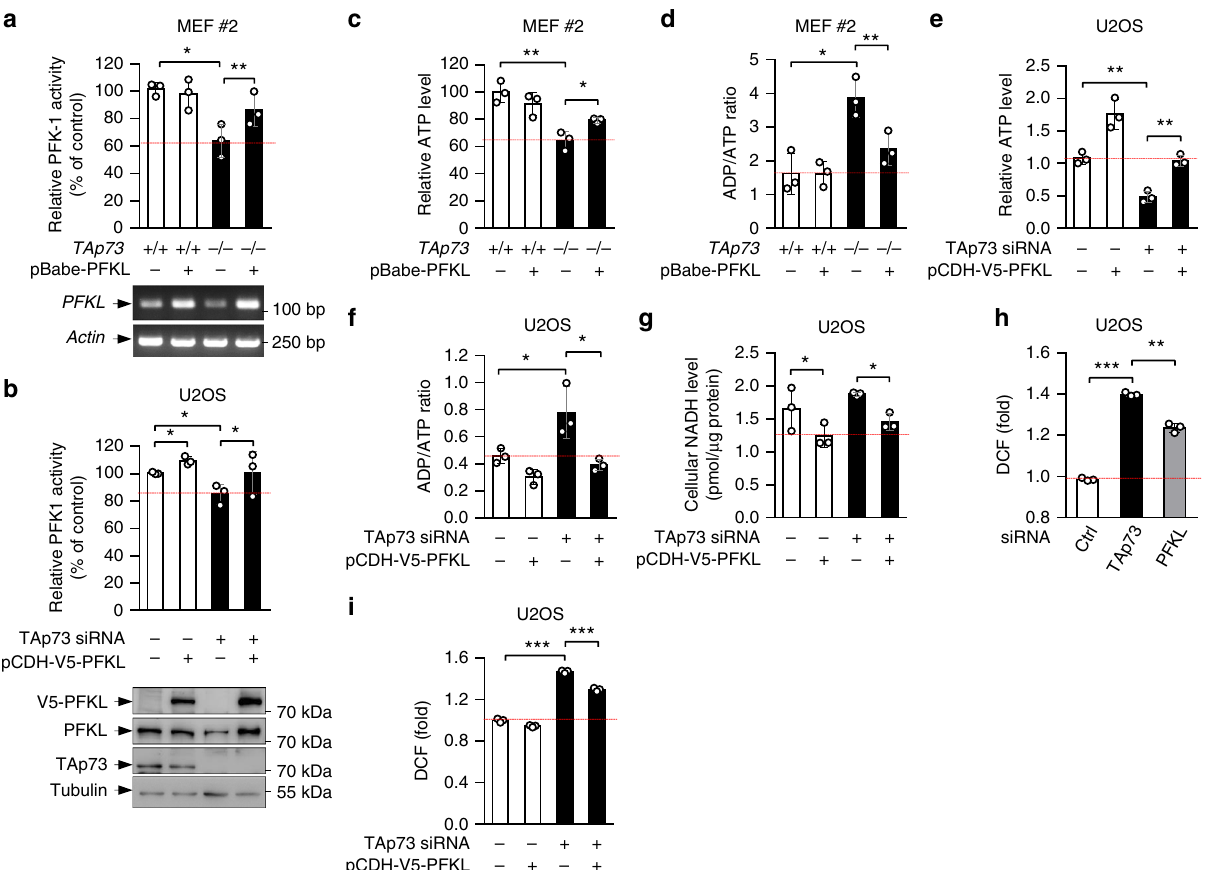
Fig. 5 TAp73 regulates glycolysis, ATP production, and ROS homeostasis. a , c , d PFK-1 activity (top; means ± S.D., n = 3) and PFKL mRNA levels (bottom) ( a ), ATP levels ( c ), and ADP/ATP ratio ( d ) in TAp73 + / + and TAp73 − / − MEF cells stably expressing control vector or PFKL. b , e – g , i U2OS cells stably expressing control vector or PFKL were transfected with control or TAp73 siRNA. Shown are PFK-1 activity (top; means ± S.D., n = 3) and PFKL protein levels (bottom) ( b ), relative ATP levels ( e ), ADP/ATP ratio ( f ), NADH levels ( g ), and relative ROS content ( i ). Data are means± S.D. (n = 3) h U2OS cells treated with control, TAp73, or PFKL siRNA were assayed for ROS accumulation by 2 ′ 7 ′ -dichlorodihydro fl uorescein diacetate (DCF) staining and FACS analysis. Data are means ± S.D., n =